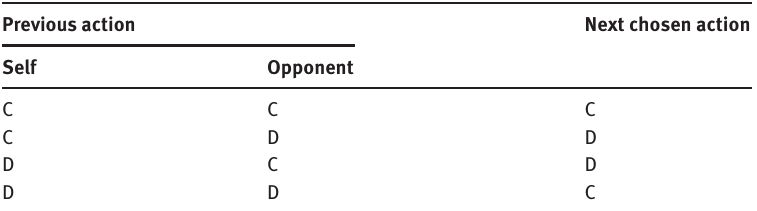
Table 3 : The Pavlov Strategy Defined by the Actions Chosen in the Previous Time Step. Previous